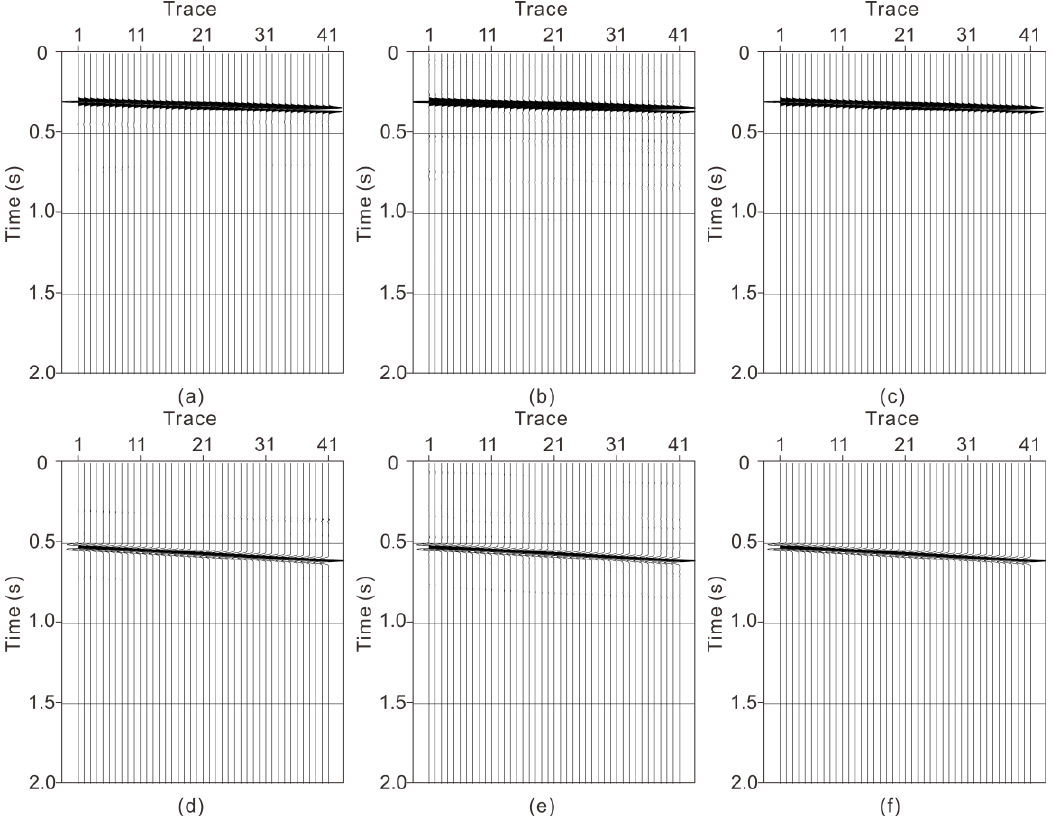
Figure 7. Results for the downgoing wavefield and theoretical wavefield. ( a ) Downgoing P-wave obtained by our method; ( b ) Downgoing P-wave obtained by the high-resolution Radon transform; ( c ) Theoretical downgoing P-wave; ( d ) Downgoing S-wave obtained by our method; ( e ) Downgoing S-wave obtained by the high-resolution Radon transform; ( f ) Theoretical downgoing S-wave.